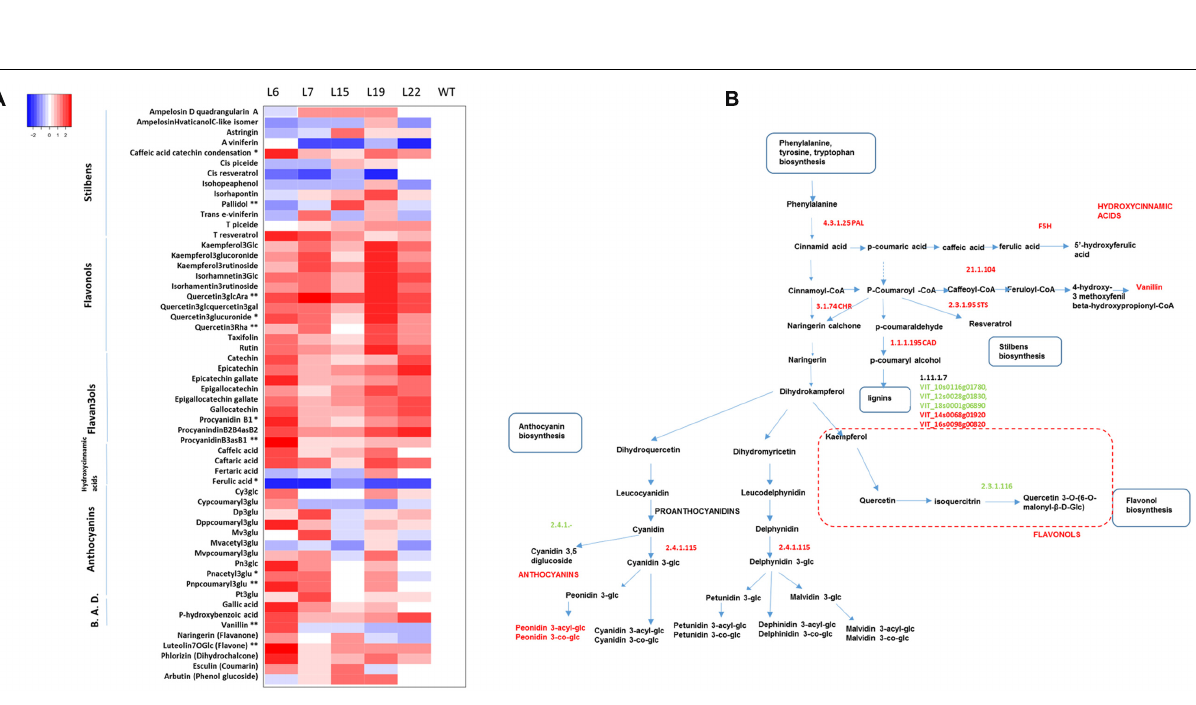
FIGURE 5 | Phenylpropanoid content in VviERF045 overexpressing lines. (A) Heatmap representation for phenylpropanoids content in the transgenic lines. For each metabolite, values are scaled by subtracting the WT mean value and dividing by the SD. ( ∗ ) and ( ∗∗ ) respectively indicates significant differences ( p < 0.05), and highly significant differences ( p < 0.01). A legend with the color scale is reported on the top left part. B.A.D., Benzoic acid derivative. (B) Transcripts involved in their biosynthesis. 4.3.1.25 Phenylalanine ammonium lyase (PAL) ( VIT_16s0039g01170, VIT_16s0039g01240, VIT_16s0039g01280,